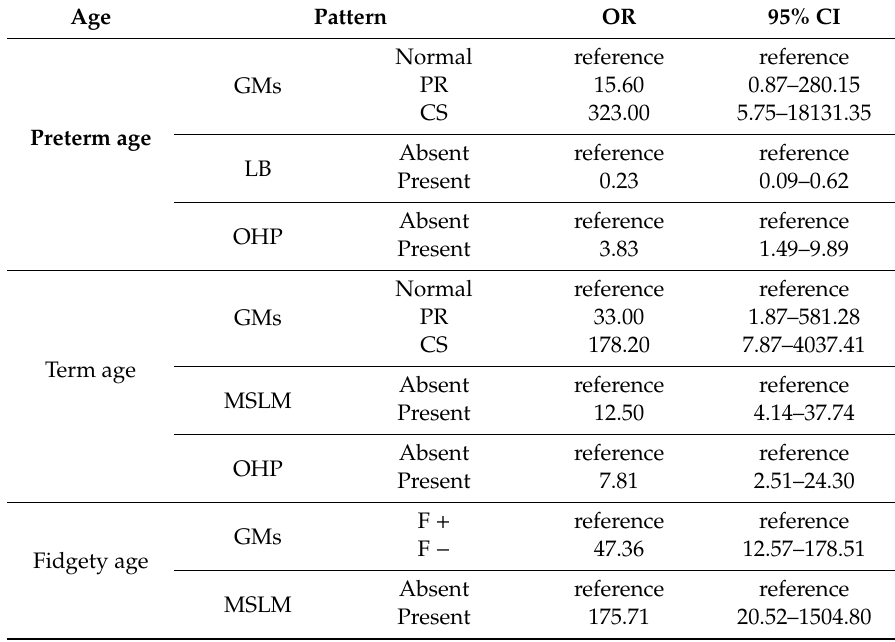
Table 7. Concomitant motor and postural patterns that along with GMs increase their association with cerebral